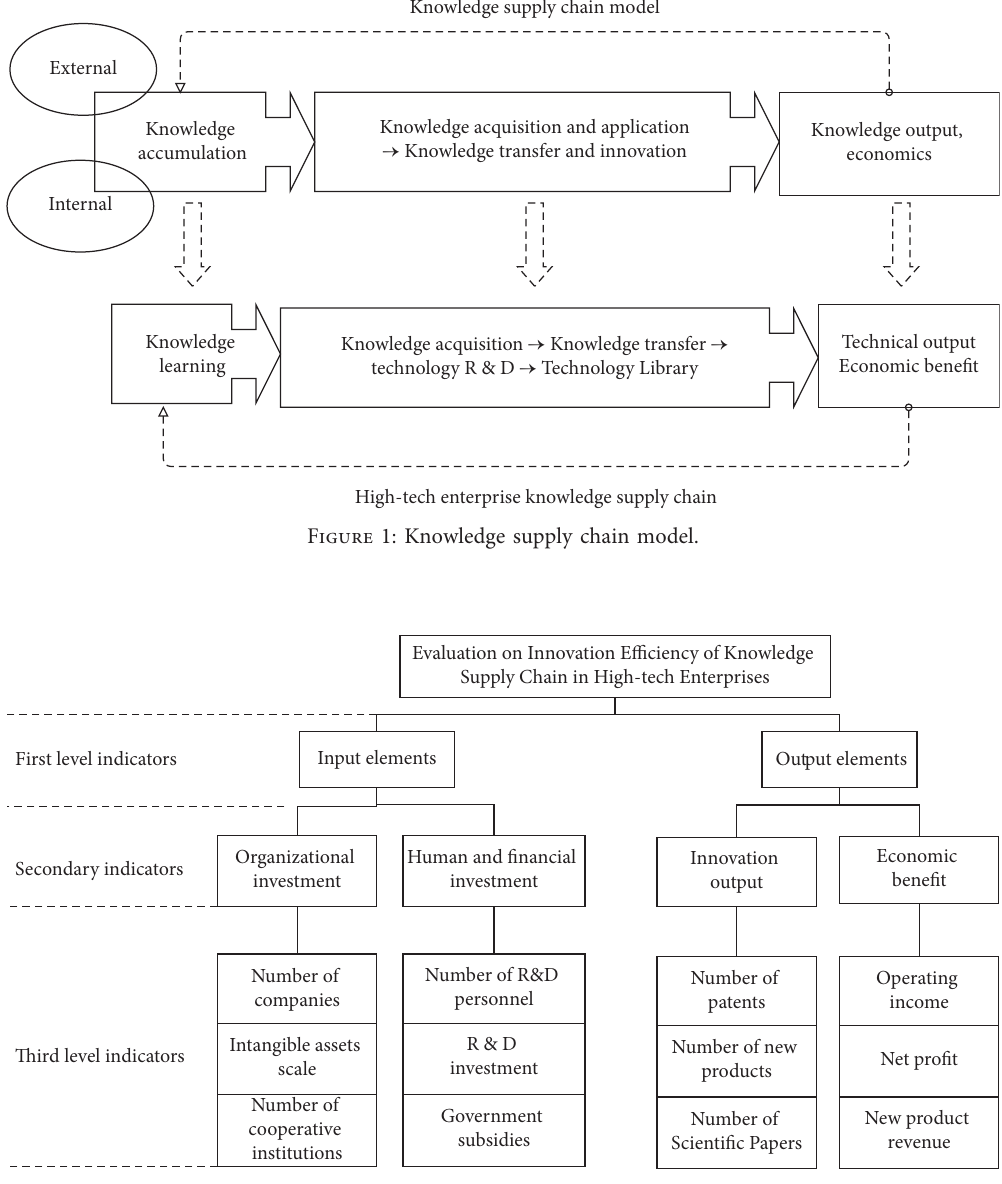
Figure 2: Innovation efficiency evaluation